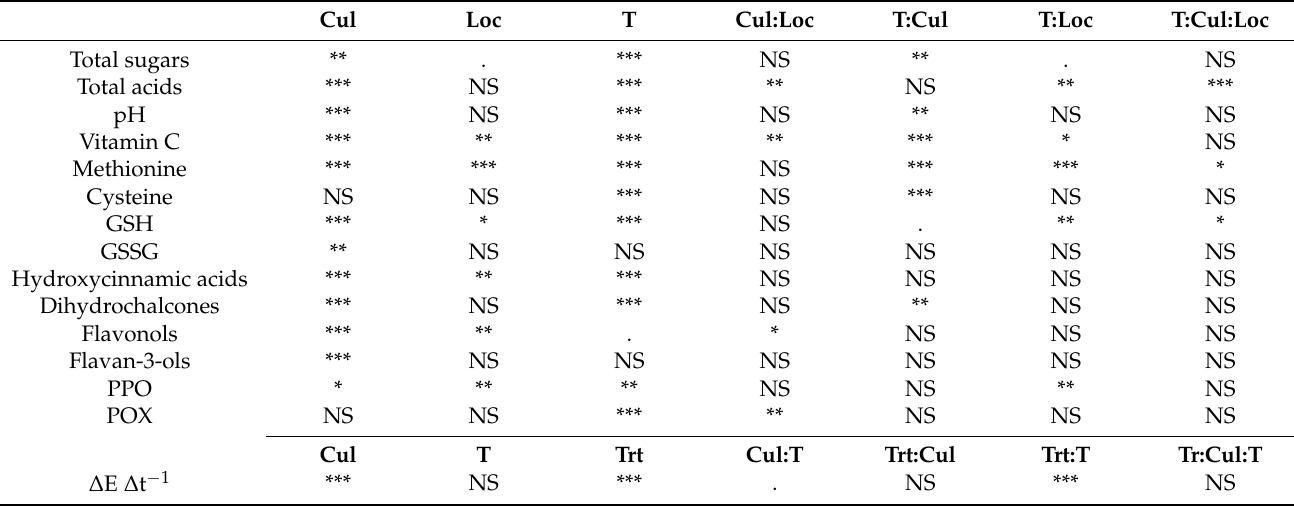
Table 1. Three-factor ANOVA for cultivar (Cul: ‘Golden Delicious’ and ‘Majda’), location (Loc: L1 and L2), and time (T: harvest and storage), as well as their interactions ( p < 0.05). Cul Loc T T:Cul:Loc Total sugars .